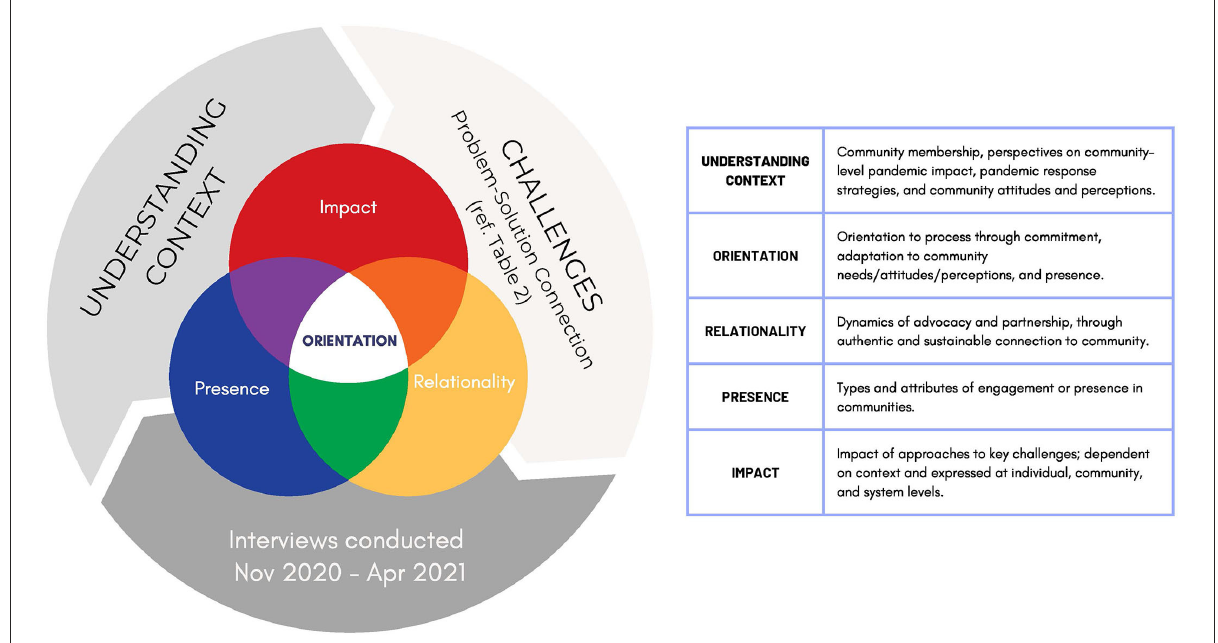
FIGURE1 A visual representation of iterative cycle relationships between themes.